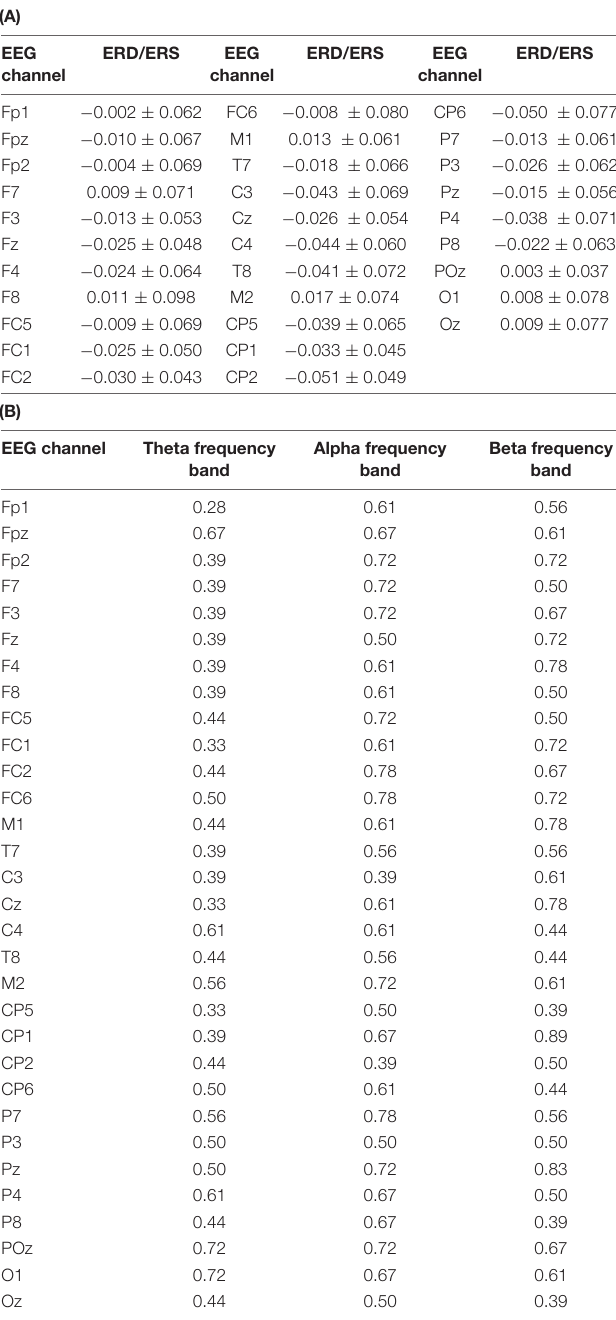
TABLE 1 | The ERD or ERS (mean ± SD) is calculated by subtracting the logarithm of the power spectral densities during the resting stage from that during the activation stage in all channels in Table